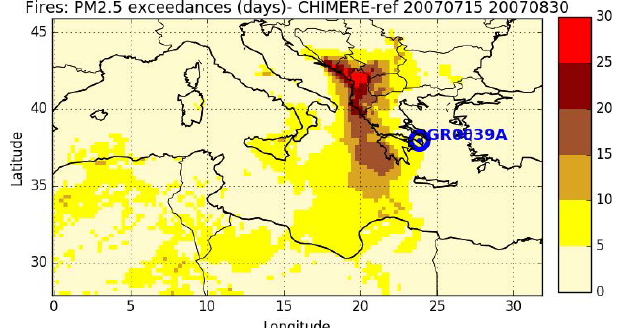
Figure G1. The additional days with PM 2 . 5 exceedances due to fires simulated by CHIMERE (difference between CHIMERE-ref and CHIMERE-Nofires ) during the summer of 2007 (from 15 July to 30 August